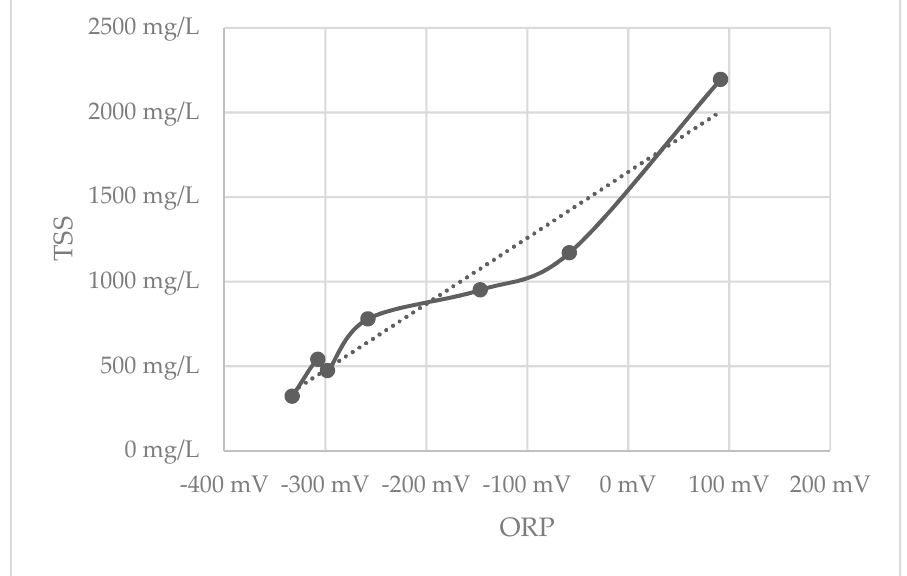
Figure 4. Correlation between ORP and TSS. The mean AT reactor TSS concentration plotted against the mean AT reactor ORP during the study period. The R 2 value of the linear regression line is 0.94.